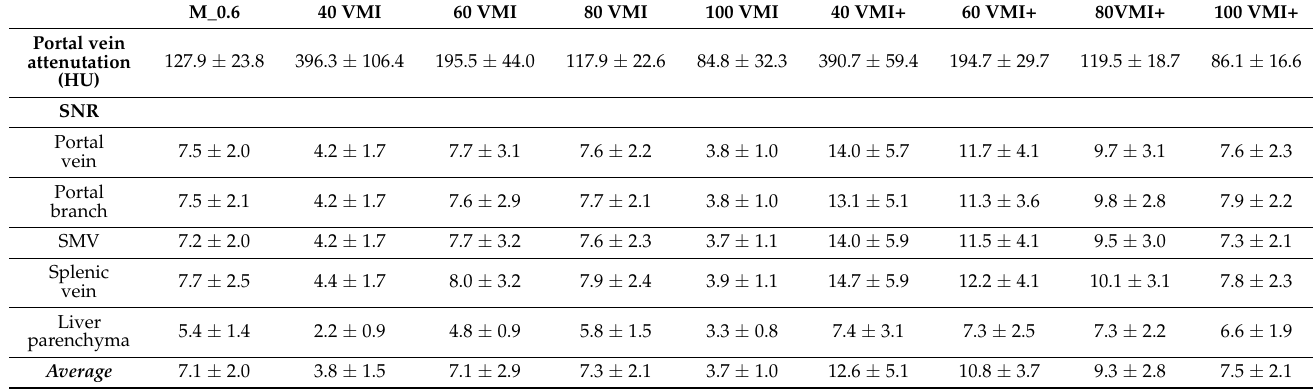
Table 2. Quantitative image analysis. Portal vein attenuation (HU), signal-to-noise (SNR) and contrast-to-noise ratio (CNR) were compared between linearly blended M_0.6, standard virtual monoenergetic imaging (VMI), and noise-optimized VMI+ series at different keV-levels in various selected abdominal